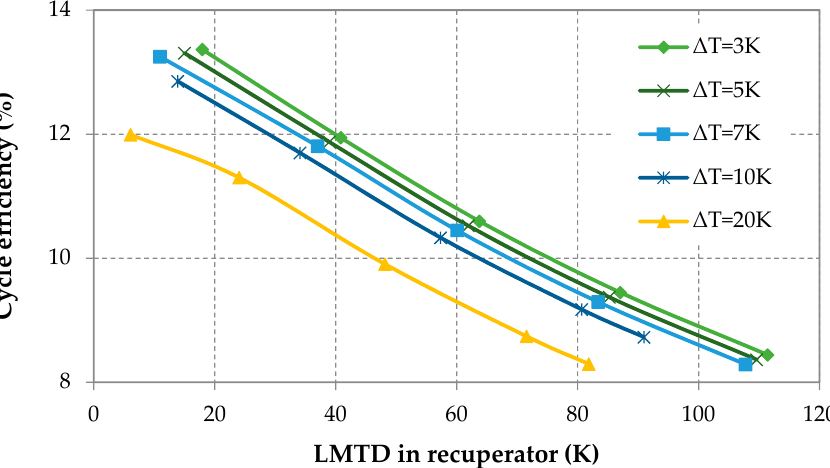
Figure 8. Relationship between the LMTD and cycle efficiency for varied temperature differences between CO 2 and the exhaust gases at the inlet and outlet of the heat exchanger.